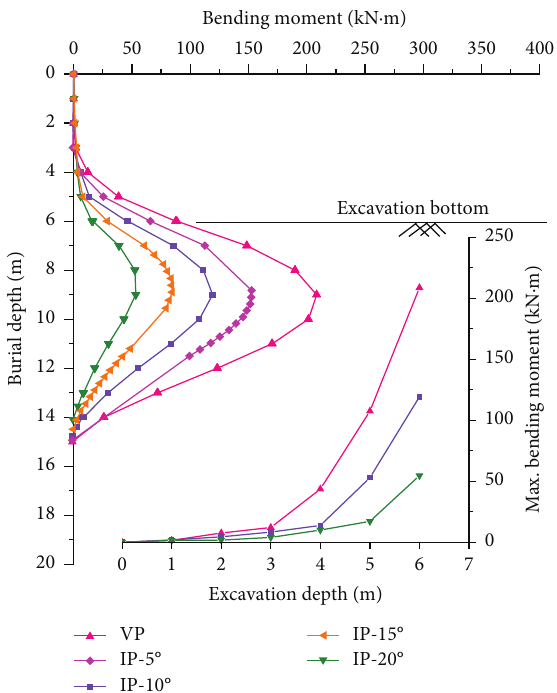
Figure 10: Bending moments of VP and IP.